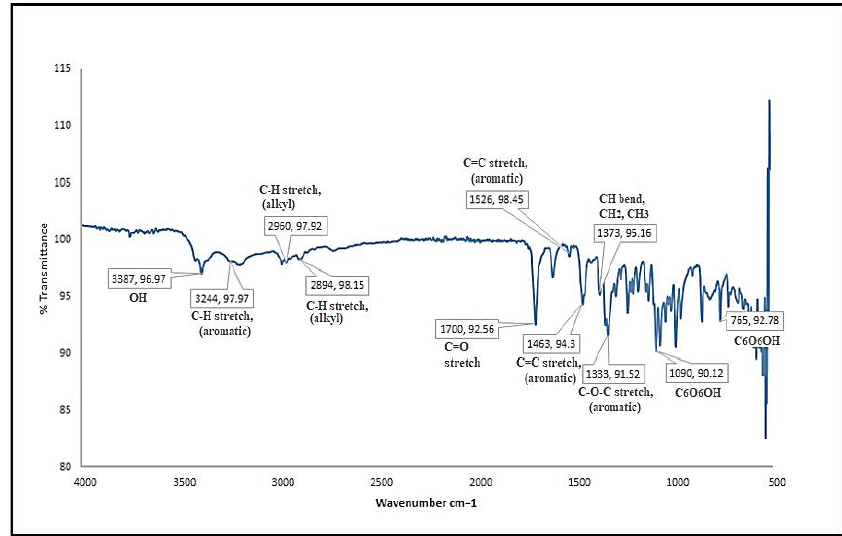
Figure 2. FTIR spectra of bergenin isolated from B. ciliata.